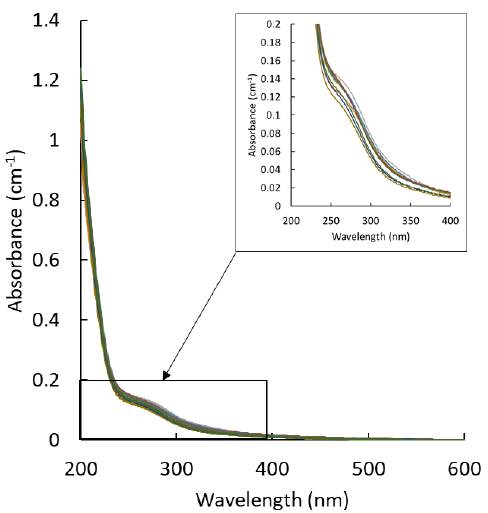
Figure 5. Spectra collected during lab-scale photolysis experiment A with an enlargement of the zone used for the calculation of SUVA 254 and the spectral slope S 275 – 295 .